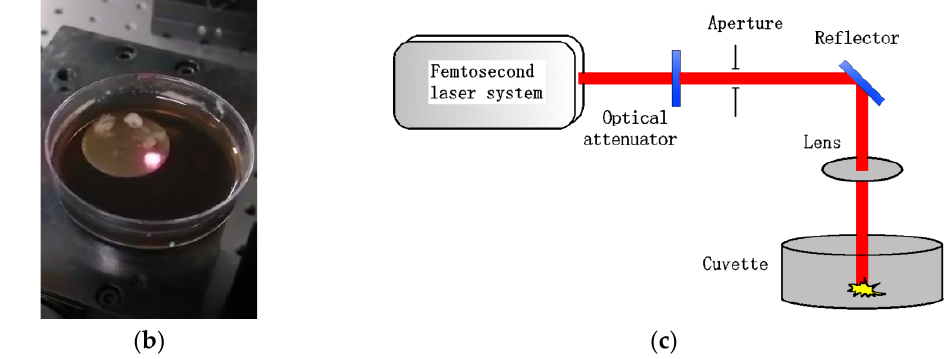
Figure 1. Experimental setup and schematic diagram of PtNPs prepared with ablation method. ( a ) Experimental setup. ( b ) PtNPs colloids in preparation. ( c ) Schematic diagram.